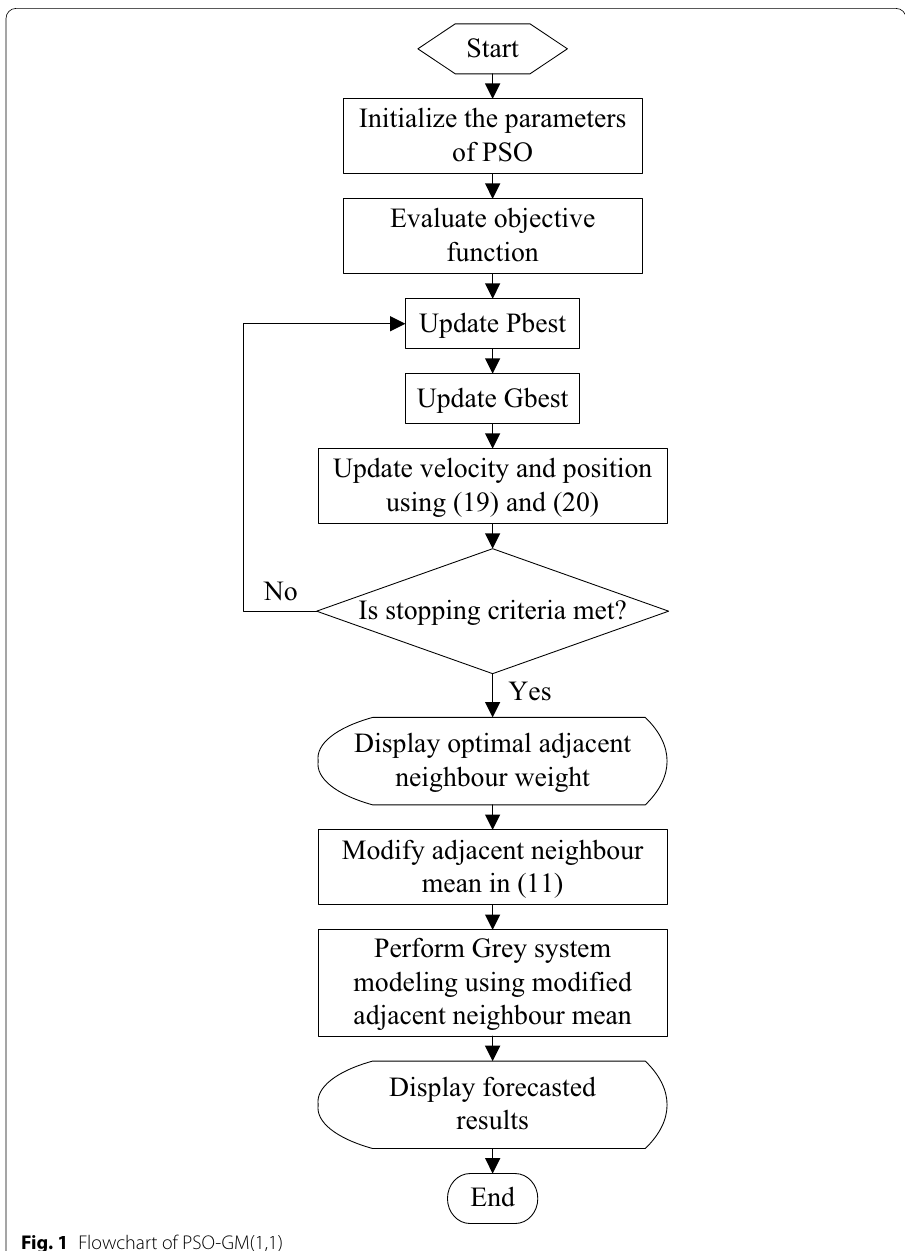
Fig. 1 Flowchart of